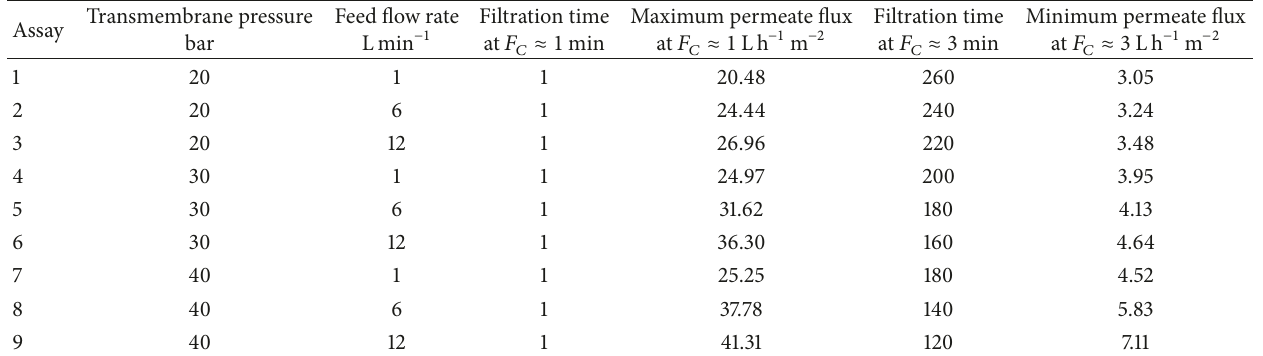
Table 3: Filtration time and permeate flux at different transmembrane pressures and feed flow rates. Transmembrane pressure Assay bar